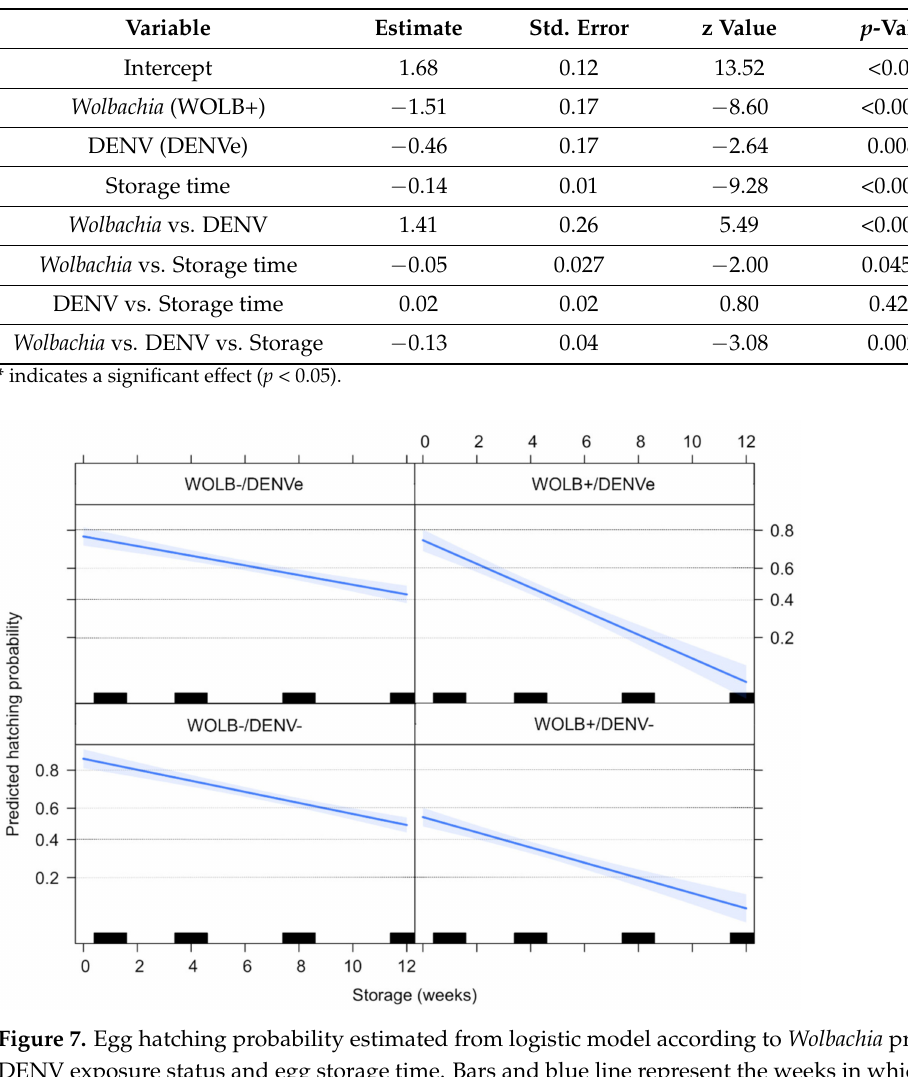
Table 4. Logistic regression for the effect of Wolbachia presence, DENV exposure and storage time on egg hatching.